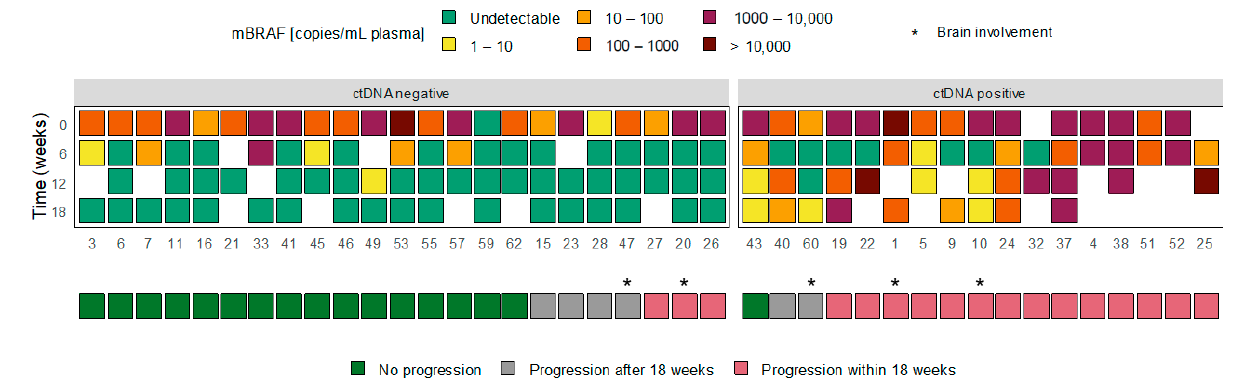
Figure 2. Overview of the ctDNA dynamics (mBRAF copies/mL plasma) related to treatment response within 18 weeks. Patients were stratified according to their ctDNA levels at 12–18 weeks, being either detectable (ctDNA positive) or undetectable (ctDNA negative).